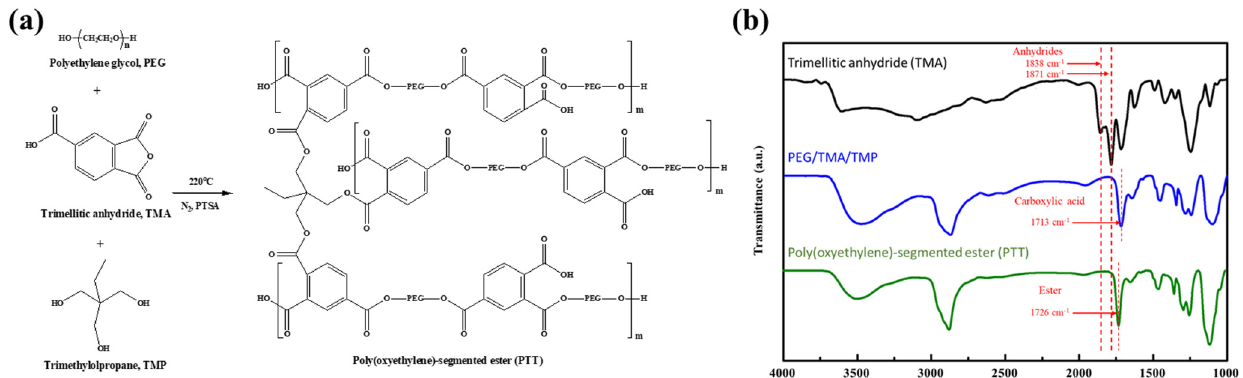
Figure 1. ( a ) Synthetic scheme for the branched polymer dispersant—Polyethylene glycol-trimethylolpropane-trimellitic anhydride (PTT). ( b ) FTIR spectrum analysis of the PTT polymeric disper- sant.